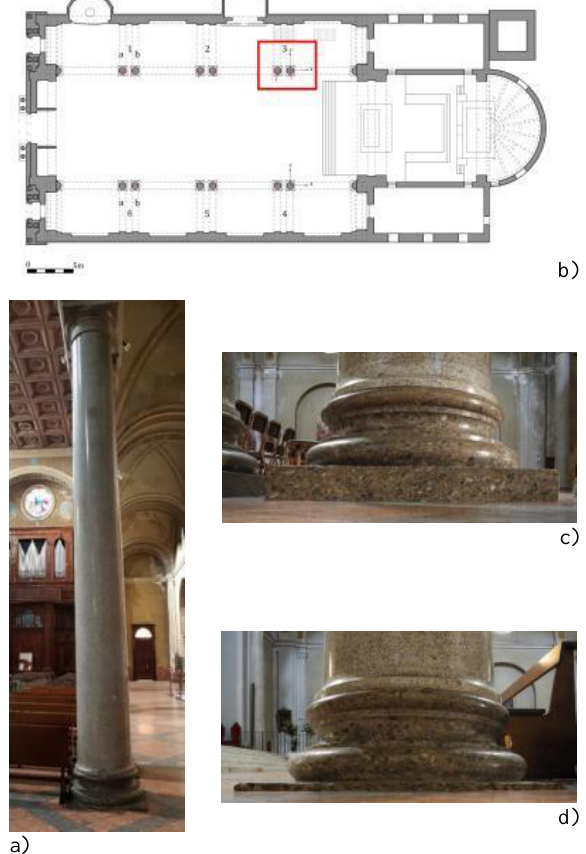
Figure 8. Column inclination and sinking of basements a) Out- of-plumb of the column near the altar on the North side and b) plan and c) base of the column near the façade and d) near the